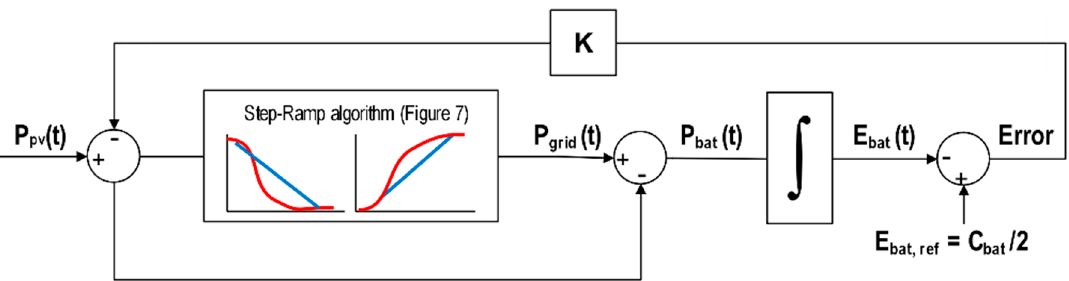
Figure 8. C ontrol diagram of Strategy 2. Figure 8. Control diagram of Strategy